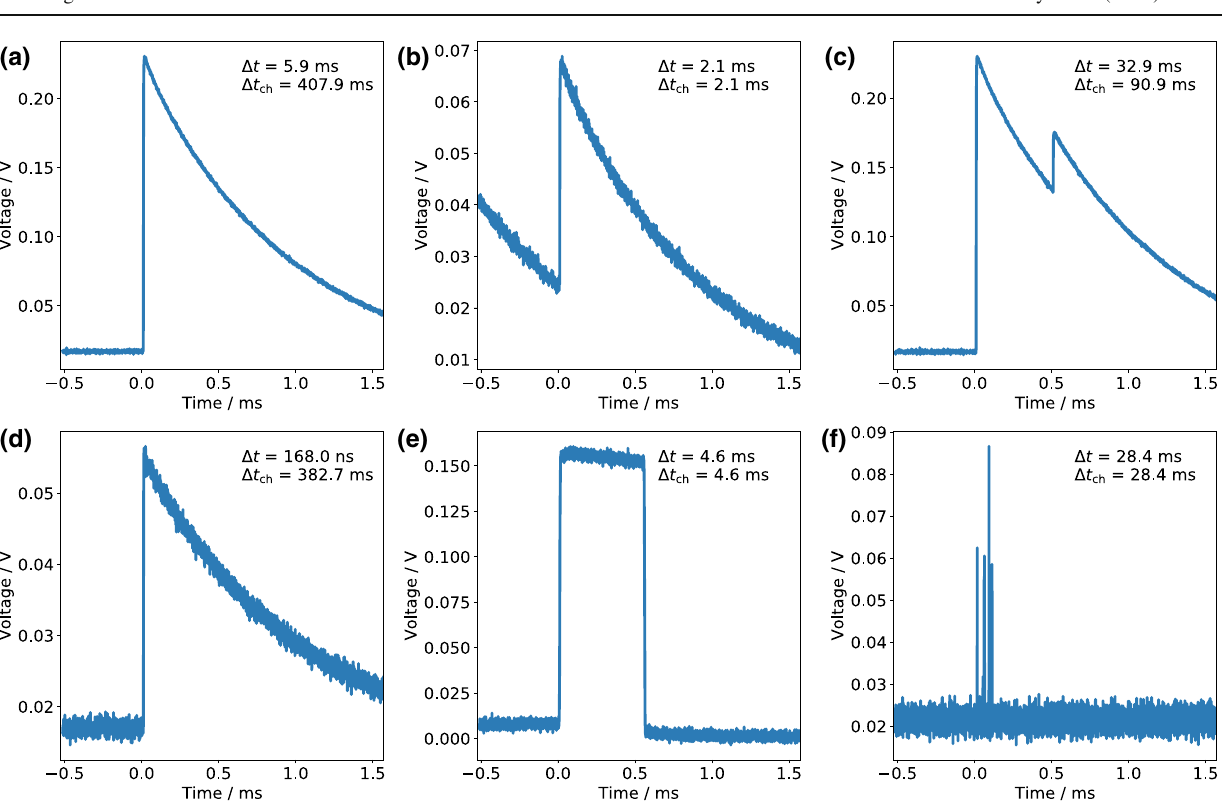
Fig. 2 a 163 Hoevent, b pileup-on-tailoutsidethetimewindow(POT), c Pileup-on-tailwithbothsignalsinsidethetimewindow(PIT), d Pixel-pixel coincidence event with thermal pulse shape, e GSM signal, f triggered noise. All traces are acquired with AC-coupled signal amplification